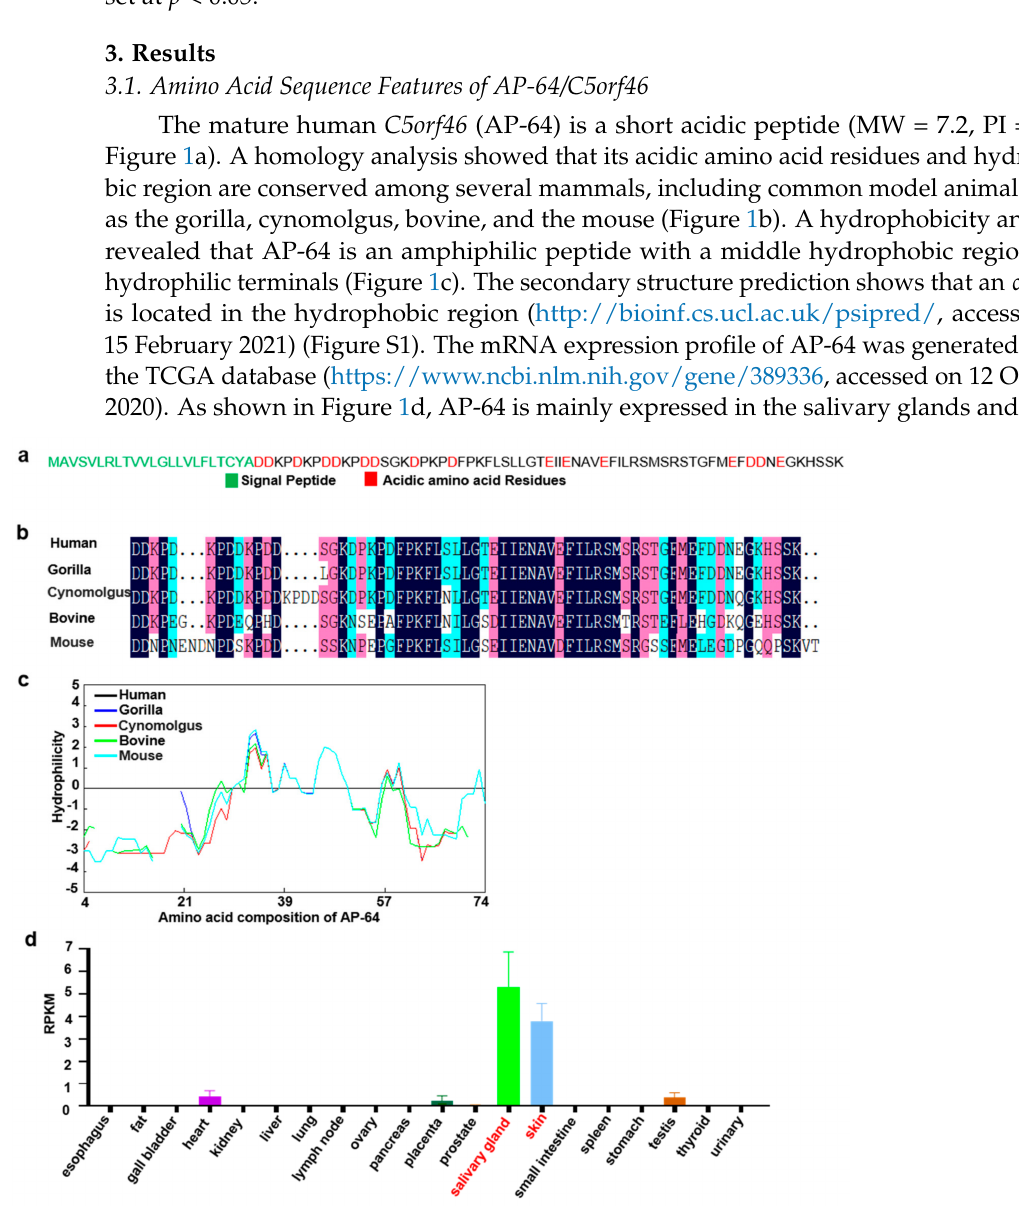
Figure 1. Features of the AP-64 amino acid sequence. ( a ) Amino acid sequence of AP-64. The signal peptide was predicted by UniProt. ( b ) Sequence conservation analysis. ( c ) Hydrophilicity analysis. ( d ) Expression analysis of the AP-64 mRNA in the TCGA database (https://www.ncbi.nlm.nih.gov/gene/389336, accessed on 12 October